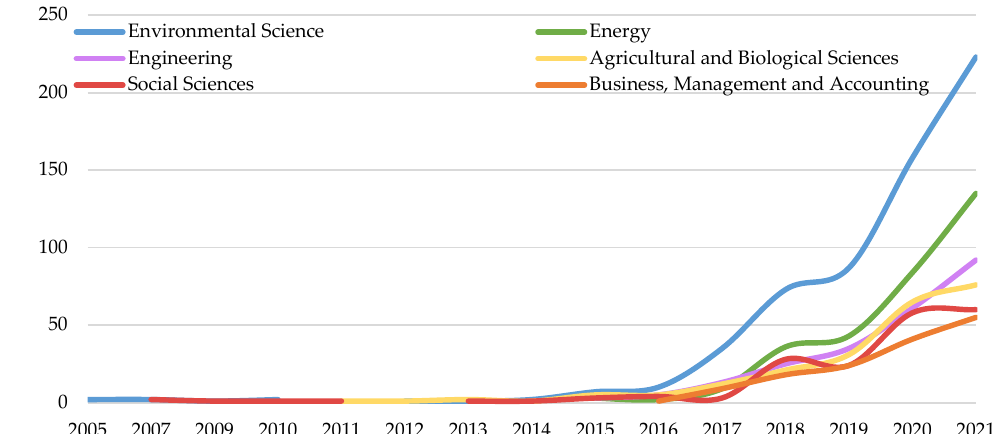
Figure 3. Comparison of the growth trends of the main subject areas (2005–2021).